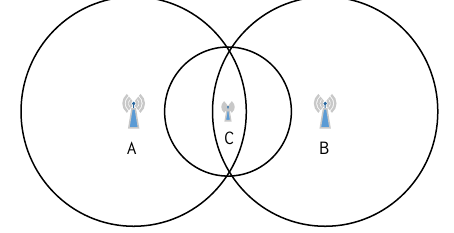
Figure 4. Three reference points are close to the collinear